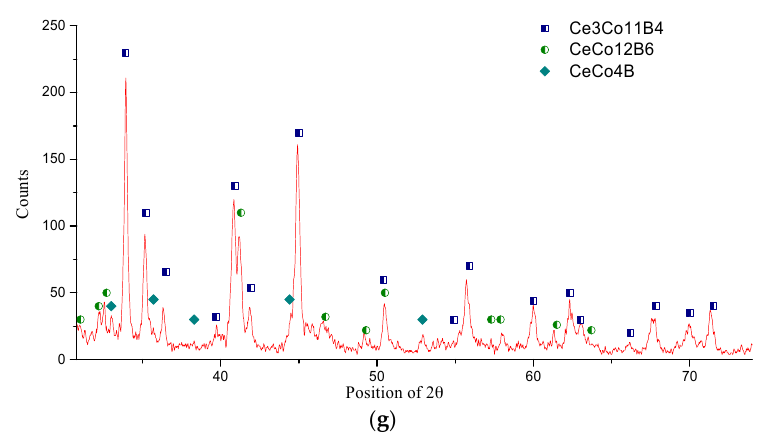
Figure 20. ( a ) BSE image of KA 11; ( b ) BSE image of KA 12; ( c ) BSE image of KA 13; ( d ) BSE image of KA 14; ( e ) MFM image of KA 11; ( f ) MFM image of KA 12; ( g ) XRD spectrum of KA 12.